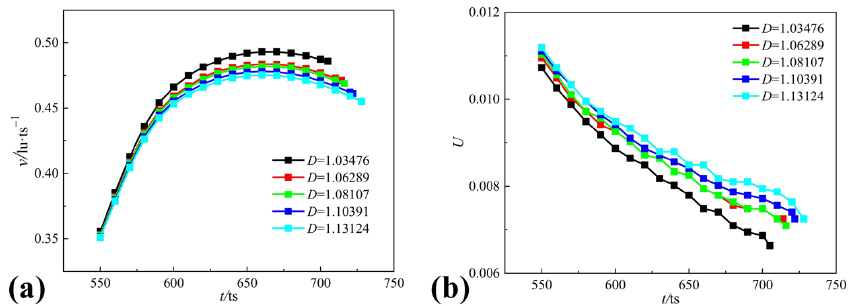
Figure 11. Jet velocity and boundary length vs. time under the different fractal dimensions: ( a ) jet velocity and ( b ) boundary length.